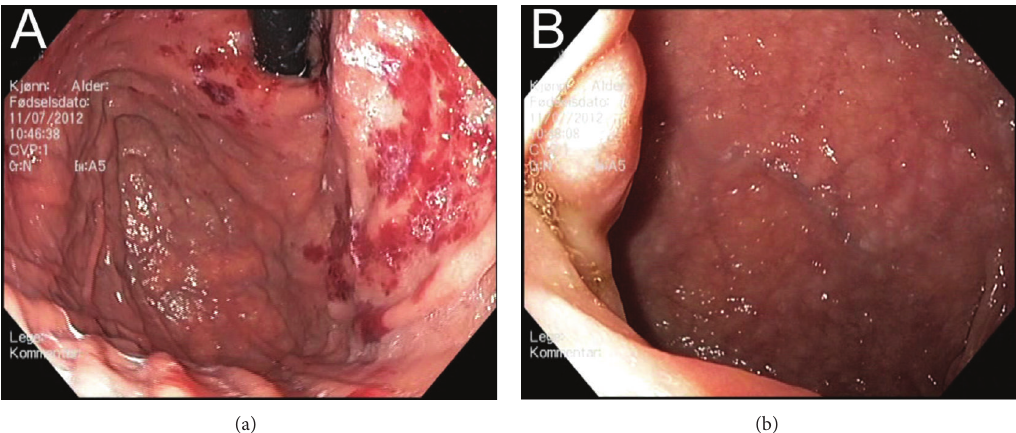
Figure1:Endoscopicappearanceofthecorpusandcardiaofthestomachwithlargeareasofintramucosalhemorrhage(a)andoftheduodenal bulb with a polypoid lesion (b).